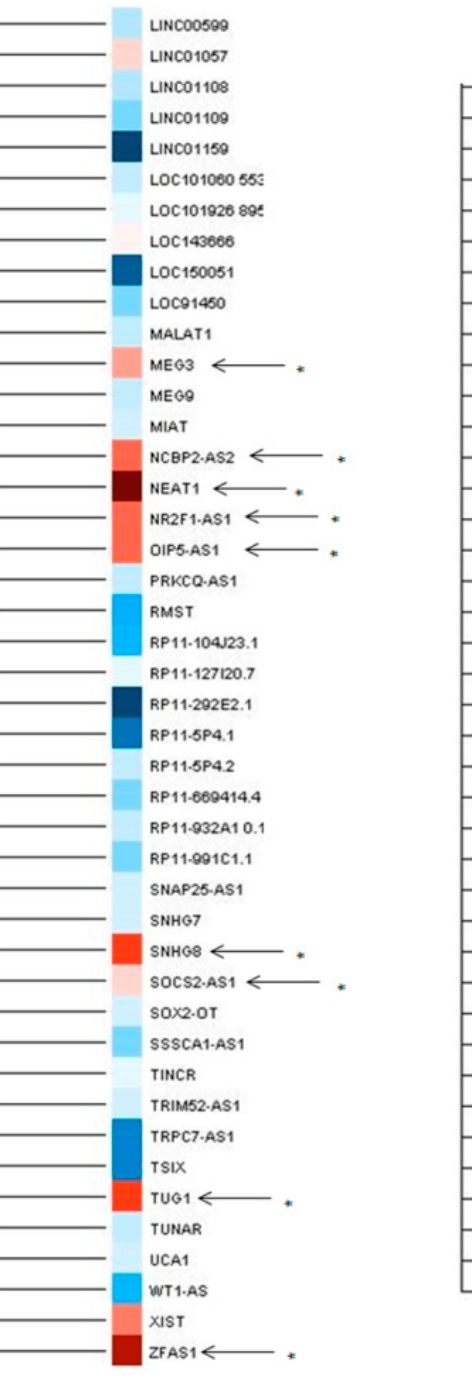
Figure 1. Long non-coding RNAs (LncRNAs) significantly present in human enteric precursor cells (EPCs). Representative heat map of the qRT-PCR experiments in human EPCs. The heat map shows the positive (red) or negative (blue) expression levels of lncRNA in human EPCs. Arrow and asterisk indicate the 13 lncRNA with a statistically significant presence. The color scale represents the Δ C t plus, shown on the right side. Cycle threshold ( C t) = 34.